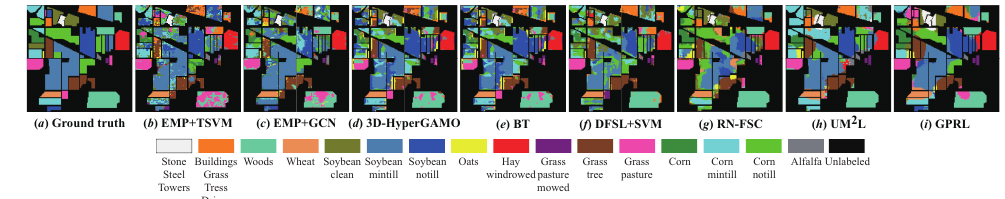
Figure 9. The classification maps of different methods on the IP data set.